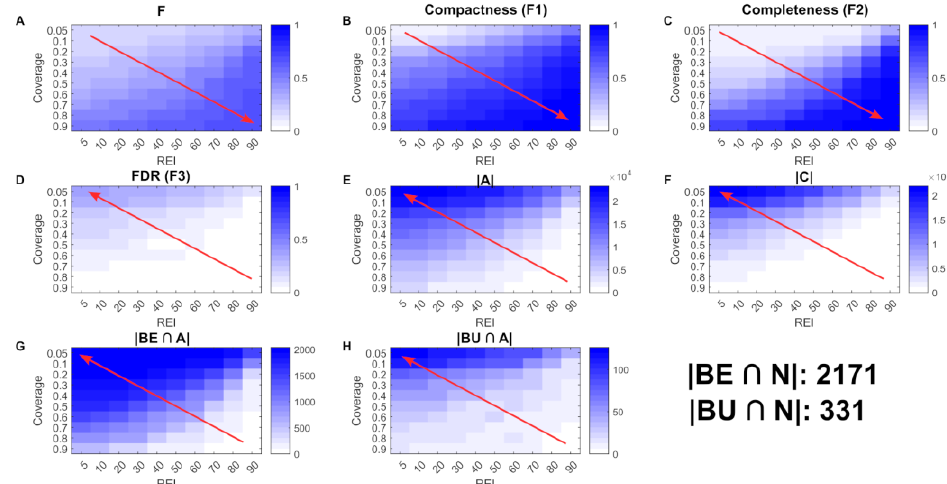
Figure 2. Parameter optimization. A Pareto optimization (F score, subfigure ( A )) was performed to determine the parameter setting (Ranked Expression Intensity and coverage) that conciliates the 3 objectives: compactness (F1, subfigure ( B )), completeness (F2, subfigure ( C )) and specificity (F3, subfigure ( D )). The heat maps display the scores for F, F1, F2, and F3, the number of reactions in the multi-cell population model (A, subfigure ( E )) and core reactions (C, subfigure ( F )), as well as the number of reactions included in the multi-cell population model identified to be always active (BE, subfigure ( G )) and inactive by the bulk data (BU, subfigure ( H )). The lighter the colour, the lower the F, F1, F2, F3 and the other factors used in the Pareto optimization. The red arrows indicate the way in which the F scores increase with the different parameter settings of coverage and REI.